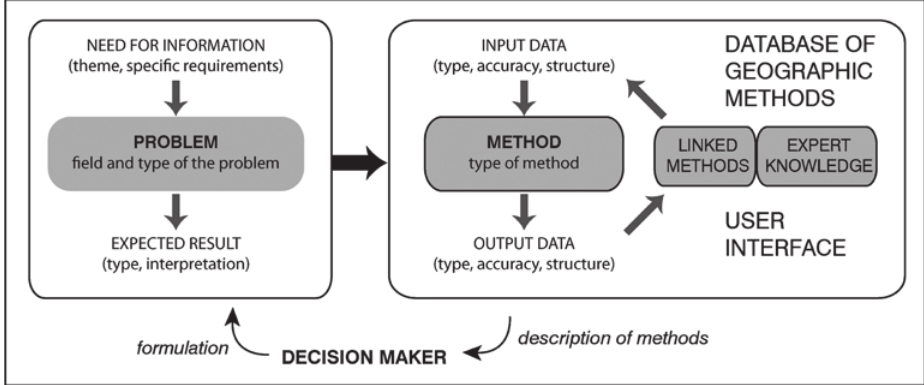
Fig. 5. A model of description of geographic